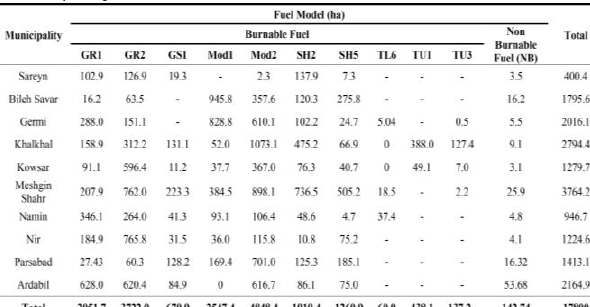
Table 1. Area in burnable and non-burnable fuel models by